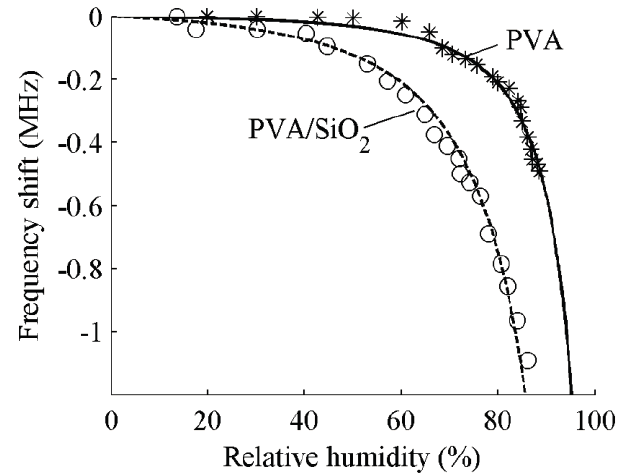
Figure 4. Frequency shifts versus relative humidity for ST-90°X quartz substrate/PVA and ST-90°X quartz substrate/SiO 2 /PVA devices.